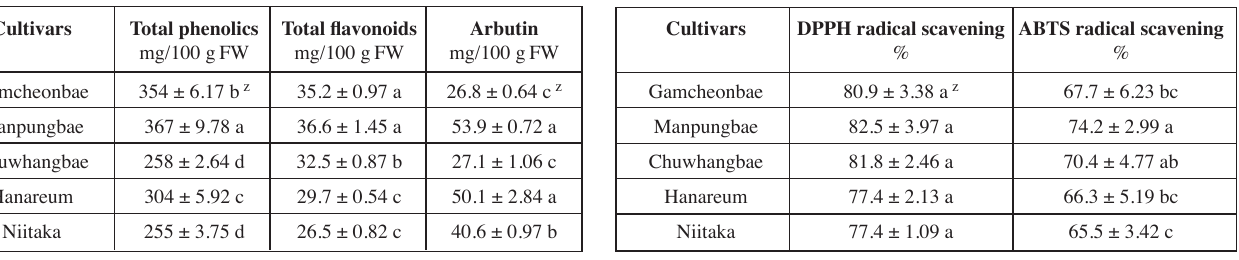
Tab. 2: DPPH and ABTS radical scavenging of five young pear